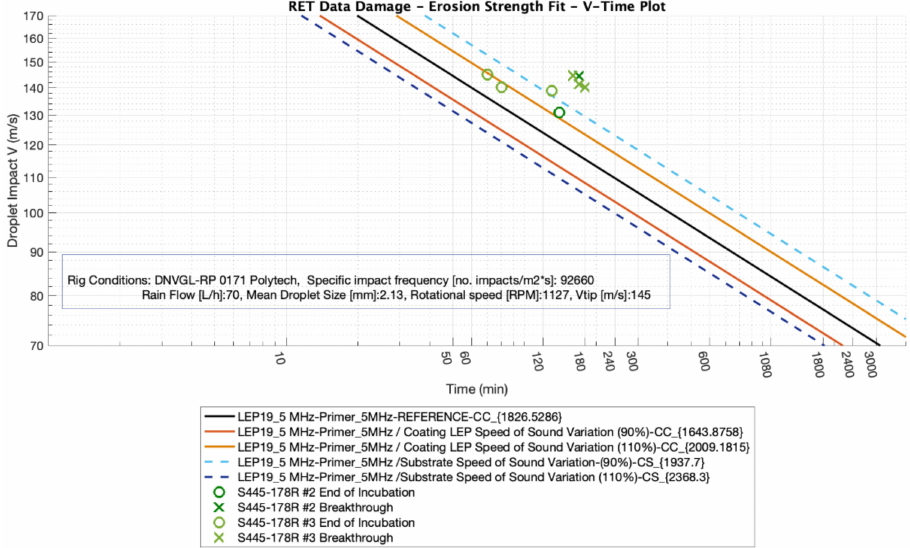
Figure 20. V-Time plot for simulated LEP prototype, comparing both the e ff ect of a 10% variation on the coating and substrate speed of sound variations.